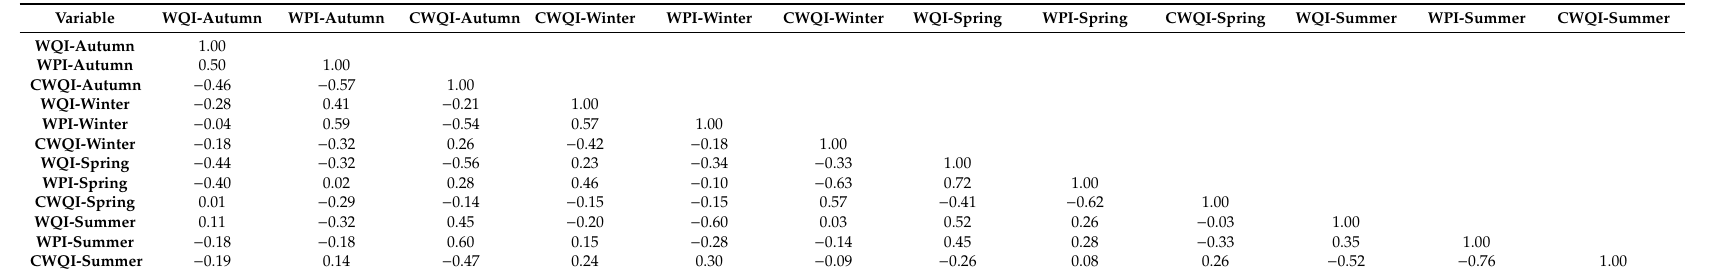
Table 8. Correlation matrix for the WQI, WPI and CCME-WQI